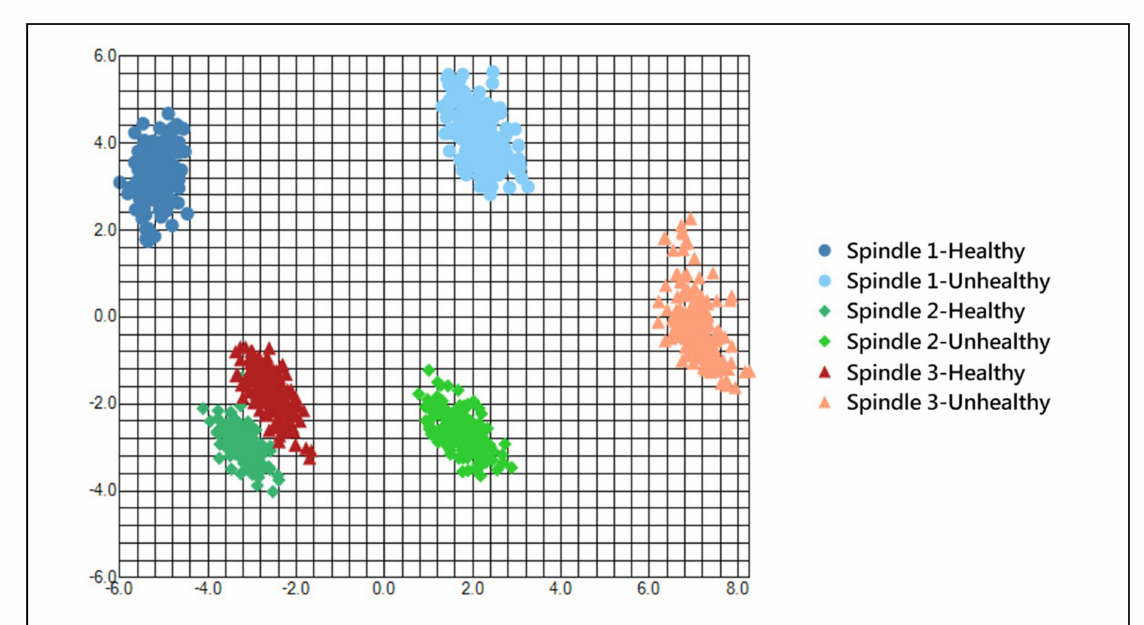
Figure 10. Spindle healthy and unhealthy distribution map.